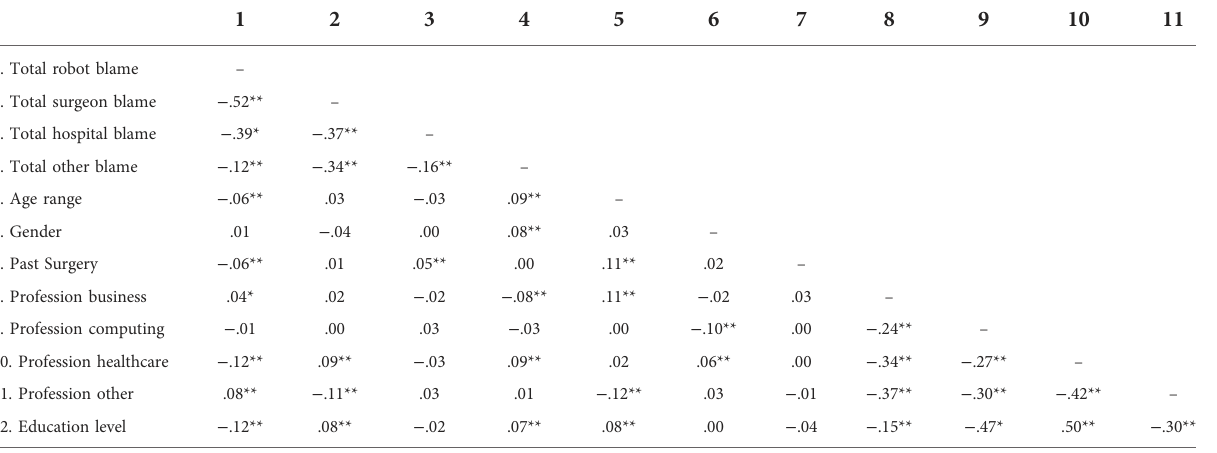
TABLE 2 Two-tailed Pearson correlations among study variables ( n =2,191).